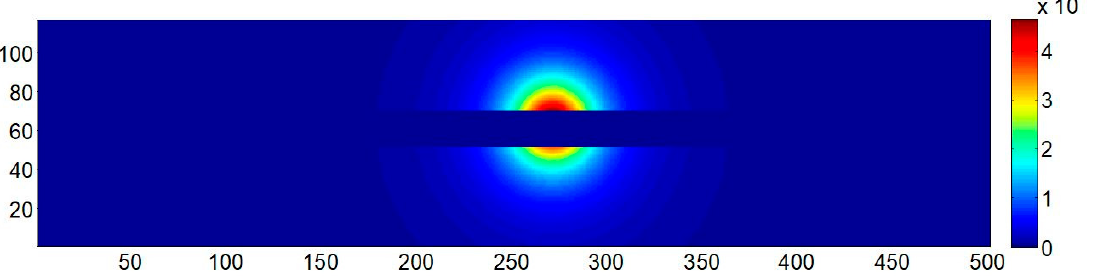
Figure 3. Solid angle values (indicated by the multicolor bar on the right), under which each ground element sees the central solar cell of the module at the location ix = 2, iy = 7 (approximately the center) of the fixed 30-module PV string. The shadow projected by such string, at the latitude of Catania, Italy, at 4 p.m. of day n. 47 of 2018, as simulated by the proposed model, is shown too. The y (east–west direction) and x (north—south direction) coordinates of Figure 1 are represented by abscissa and ordinate of the graph, respectively.